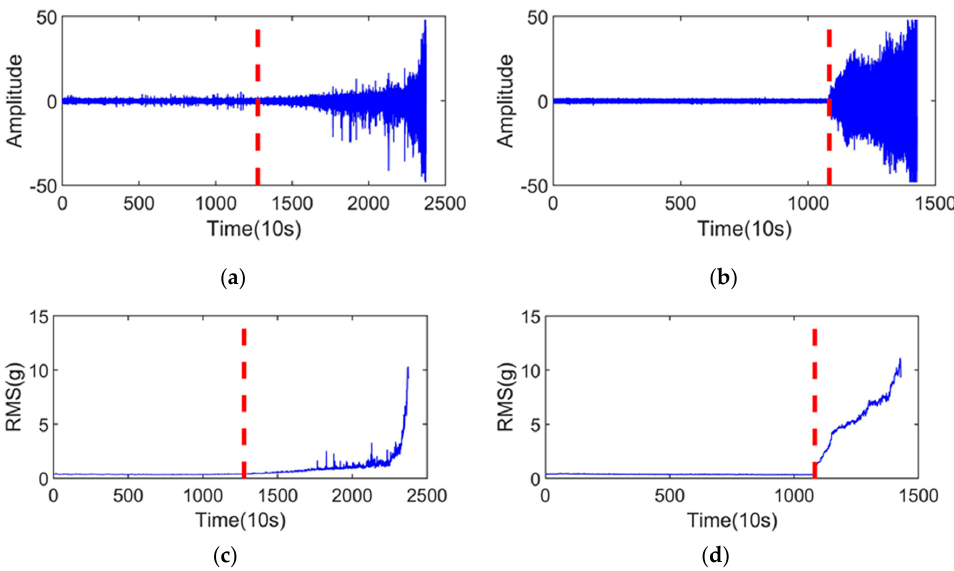
Figure 7. Vibration signals of the test sets and their RMS: ( a ) vibration signal of the bearing1_3; ( b ) vibration signal of the bearing1_4; ( c ) RMS of the bearing1_3; and ( d ) RMS of the bearing1_4. The RUL prediction results of the test sets are shown in Figure 8. It can be seen from Figure 8 that the smoothed prediction curve is quite close to the actual RUL, which can prove that the proposed method is effective for detecting the bearing degradation trend and predicting RUL.